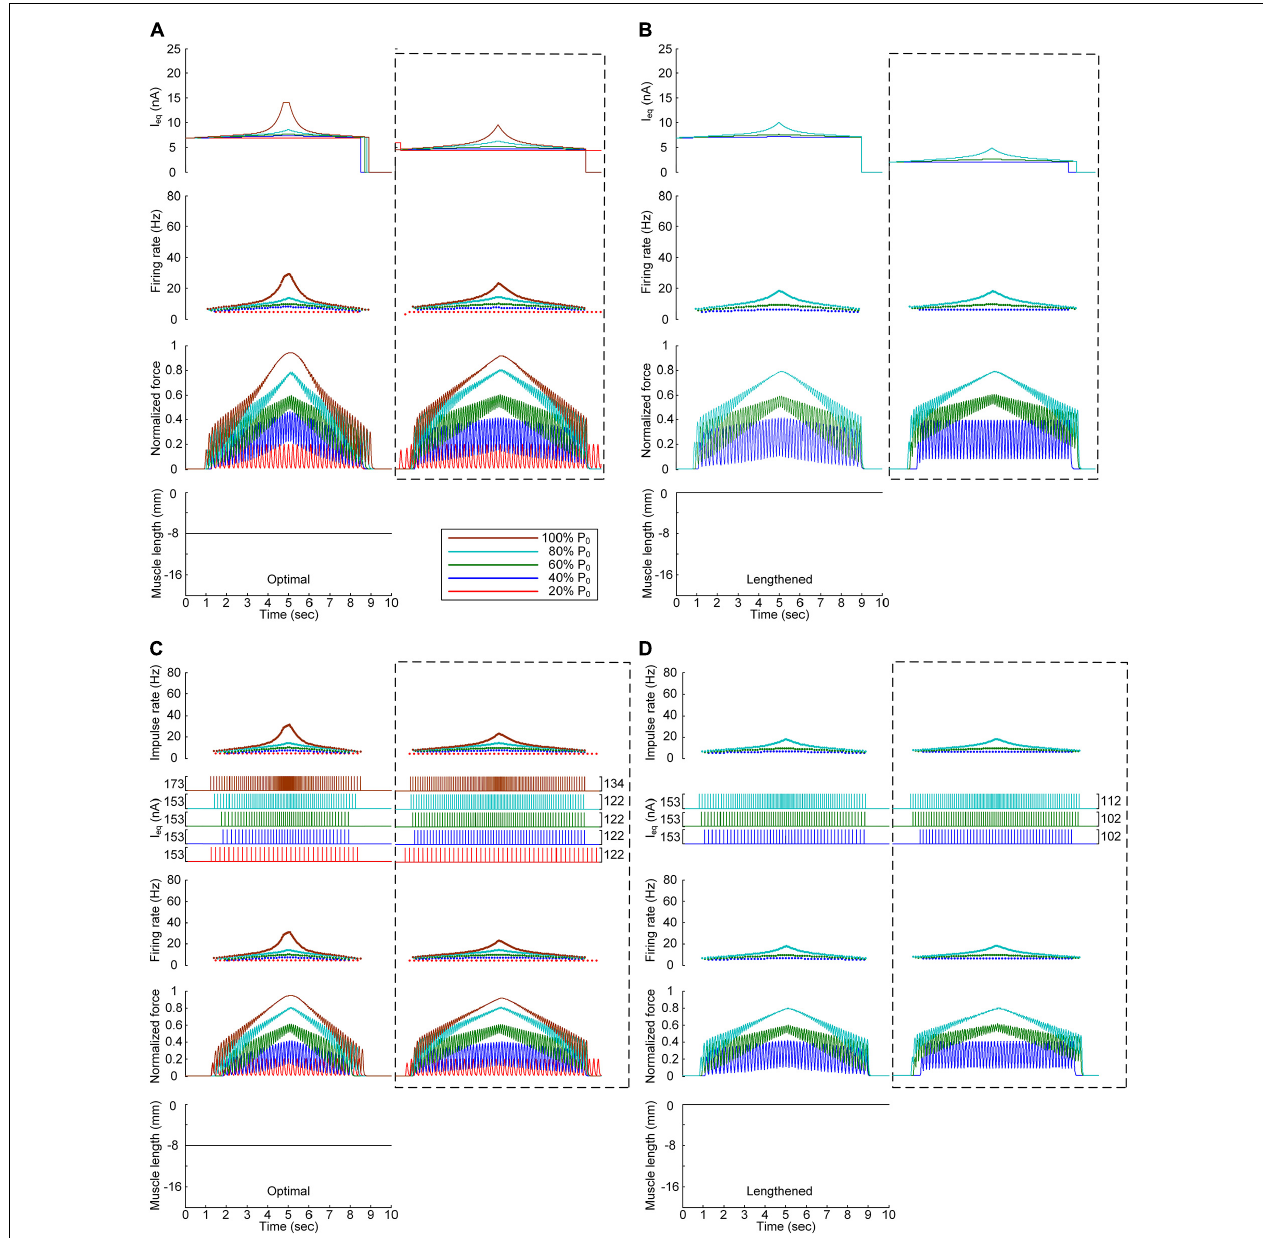
FIGURE 7 | Influence of muscle spindle feedback on the stimulation waveforms. (A,B) Intensities of continuous current stimulation ( I eq ) applied to the somatic compartment ( top ), instantaneous firing rate ( upper middle ) in the motoneuron, and normalized muscle force ( lower middle ) produced by the muscle unit at the two muscle lengths ( bottom ): physiologically optimal and maximum muscle lengths. (C,D) Frequency and amplitude (two top panels ) of impulse current stimulation (I eq ) applied to the somatic compartment, instantaneous firing rate ( upper middle ) in the motoneuron, and normalized muscle force ( lower middle ) generated by the muscle unit at the two muscle lengths ( bottom ): physiologically optimal and maximum muscle lengths. The level of force production produced by the motor unit is denoted as a percentage of the maximal isometric force (P 0 ) at the optimal muscle length and indicated with different colors. The dashed-line rectangles indicate the simulation results with the motoneuron PIC channels, as shown in Figures 3 , 4 for the purpose of